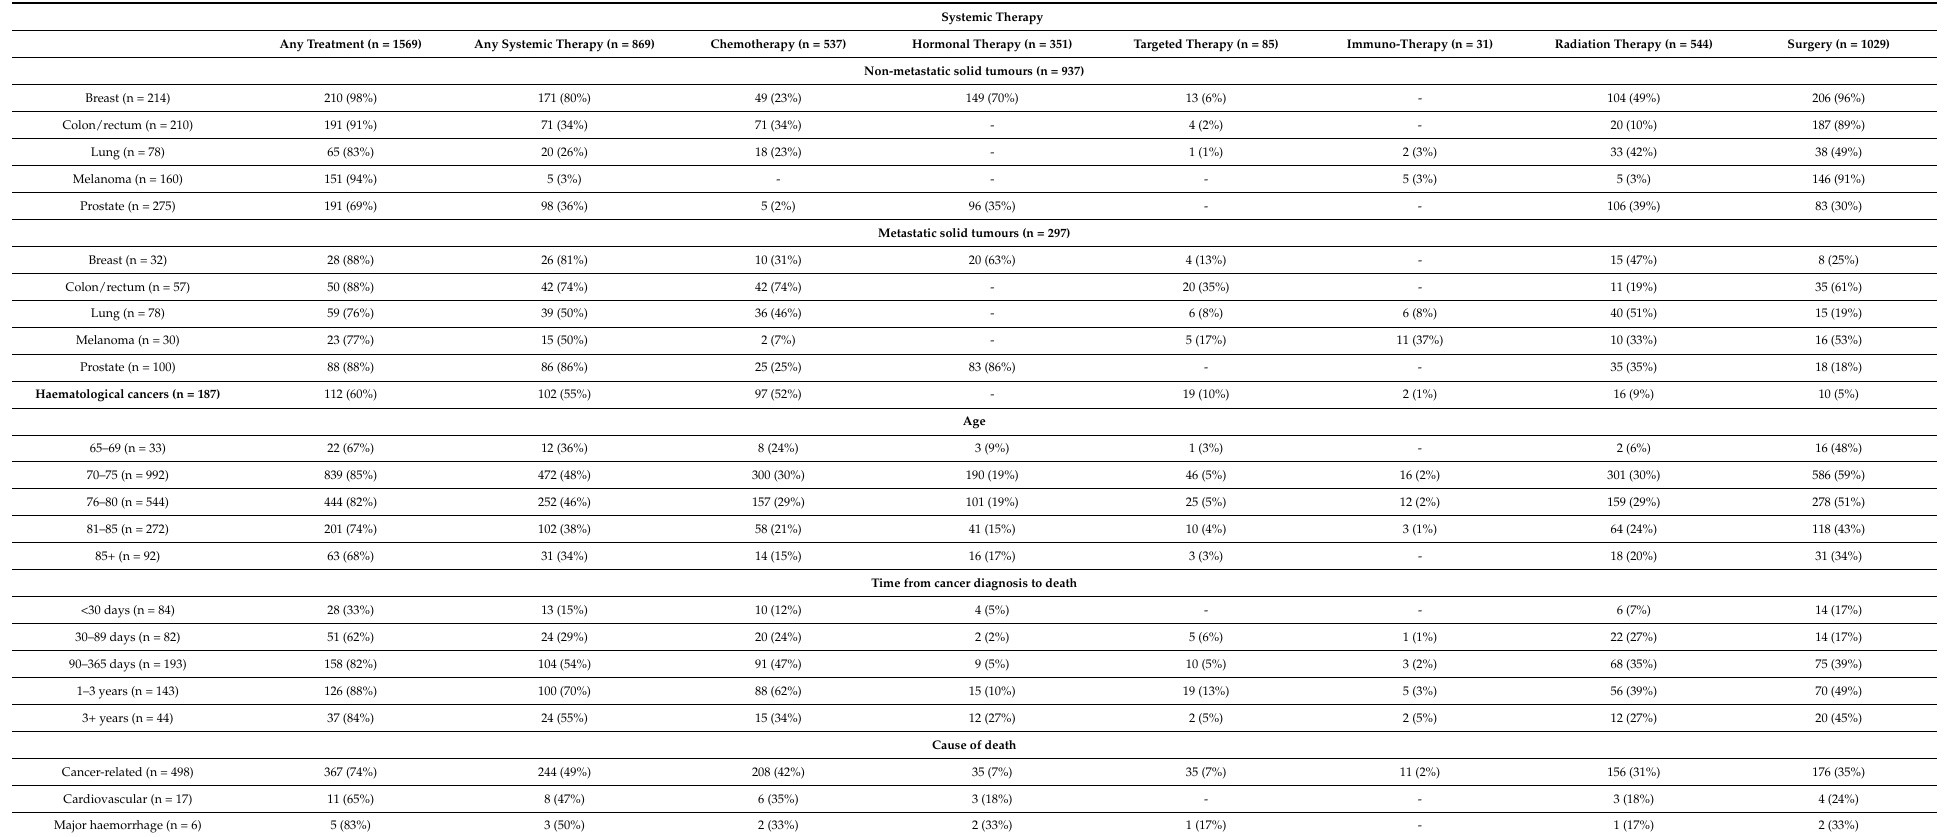
Table 3. Cancer treatment modalities received for incident post-randomisation cancers during ASPREE, stratified by most common cancer types and metastatic status, and cause of death and time from diagnosis to